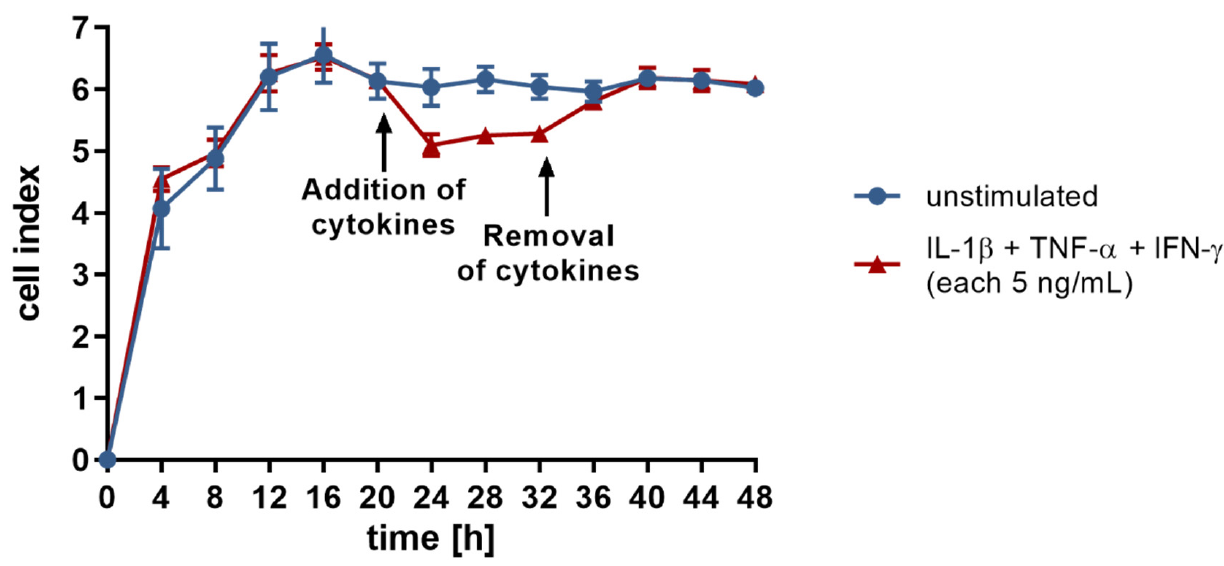
Figure 2. The cellular impedance of human endothelial cells (cell line TIME, ATCC ® number CRL-4025) was investigated in real-time using the xCELLigence ® RTCA DP instrument (ACEA Bioscience Incorporation). Changes in impedance are reported by the dimensionless parameter “cell index”. The blue and red data points symbolize cells cultured in basal cell culture medium versus medium containing 5 ng/mL each of IL-1 β , TNF- α , and IFN- γ for a defined time, respectively. The arrows indicate the time points of the performed medium changes. Three biological replicates and two technical replicates were tested in each group. Data are shown as means ± standard deviation.